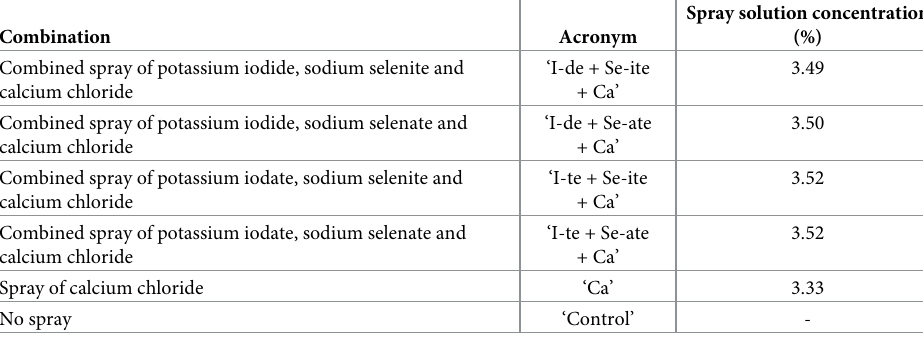
Table 2. Acronyms of the tested spray combinations and used solution concentrations in ‘Red Jonaprince’ apple orchar.